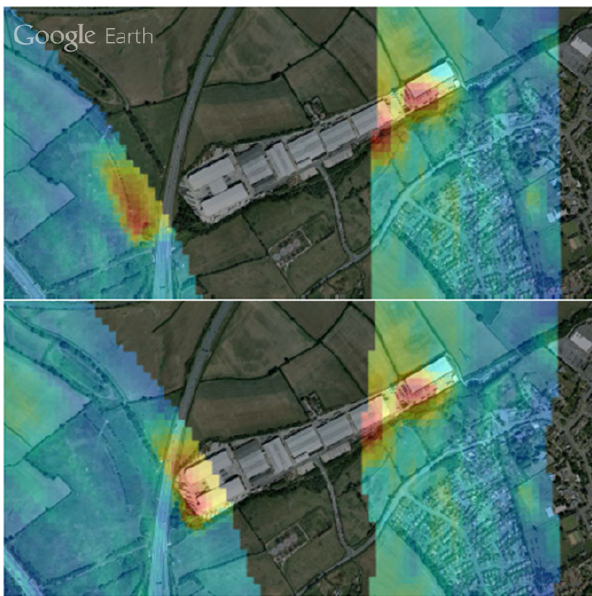
Table 2. Fitting parameters used for the DOAS fits in this